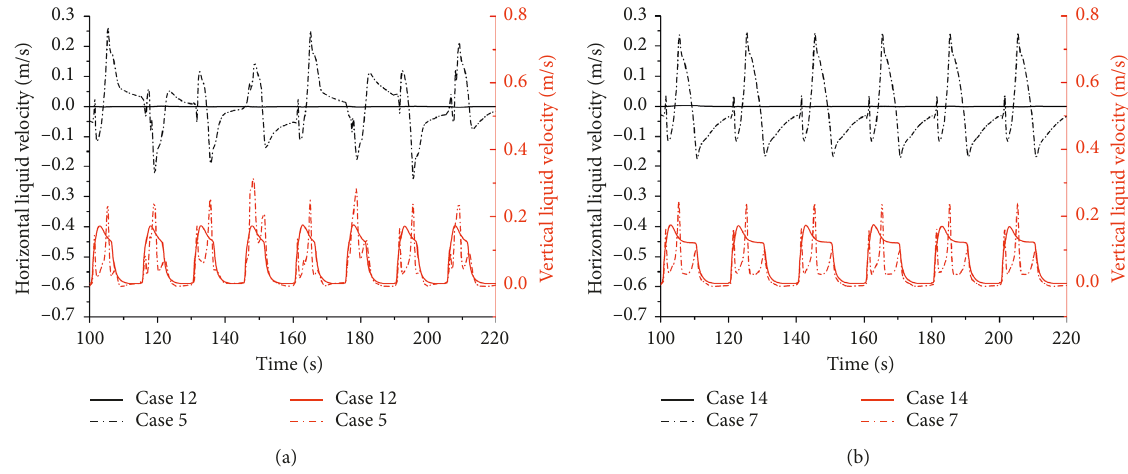
Figure 10: Instantaneous vertical and horizontal velocity of liquid phase.